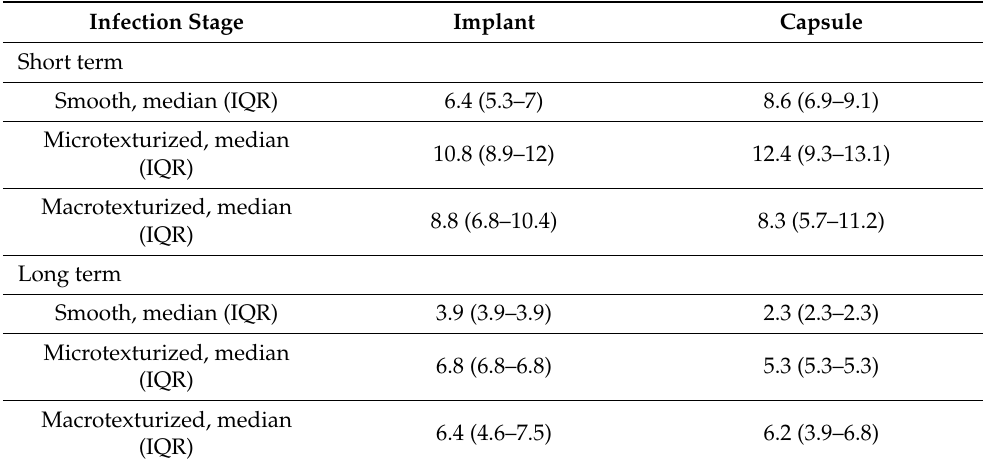
Figure 3. ( A ). Implant. Evolution of implant related infection over time. ( B ). Capsules. Evolution of capsule infections in the model over time. Table 2. Summary of median and interquartile range (IQR) of the logarithmic transformation of bacterial counts (cfu/cm 2 /g) for every implant and capsule